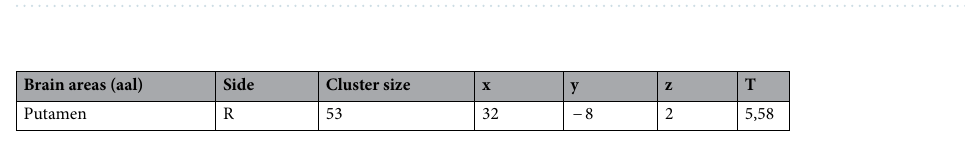
Table 2. Cluster list for contrast homosexual > heterosexual all group (threshold p < 0.05 FWE corrected at voxel level). L/R left/right in the brain.